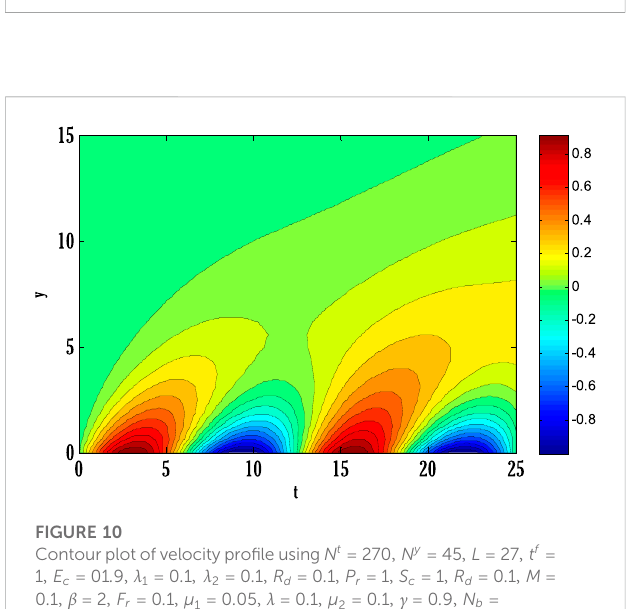
FIGURE 9 Effect of thermophoretic and Brownian motion parameters on concentrationpro fi leusing N t (cid:2) 150 , N y (cid:2) 45 , L (cid:2) 7 , t f (cid:2) 1 , E c (cid:2) 0 . 5 , λ 1 (cid:2) 0 . 1 , λ 2 (cid:2) 0 . 1 , R d (cid:2) 0 . 1 , P r (cid:2) 1 , S c (cid:2) 1 , R d (cid:2) 0 . 25 , M (cid:2) 0 . 5 , β (cid:2) 3 , F r (cid:2) 1 . 5 , μ 1 (cid:2) 0 . 05 , λ (cid:2) 0 . 5 , μ 2 (cid:2) 0 . 1 , γ (cid:2) 0 . 9 (A) N b = 0.1 (B) N t = 0.1.